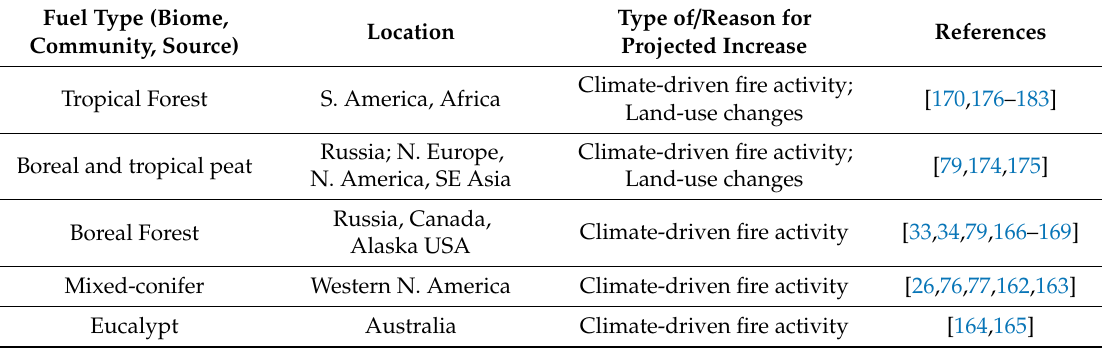
Table 4. Fuels whose contribution to total emissions, impact on climate, human populations, or regional or global processes is likely to increase in the future are listed below.